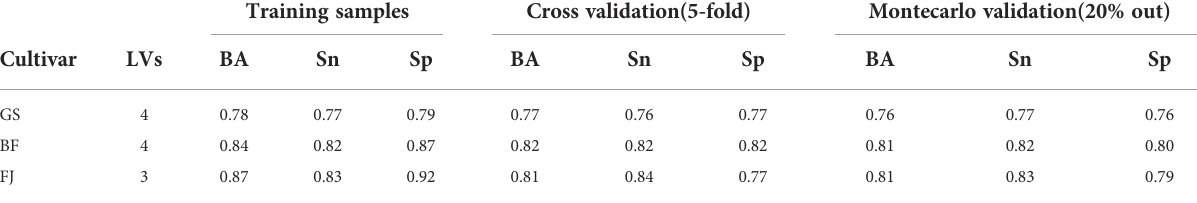
TABLE 2 Classi fi cation measures (balanced accuracy, speci fi city, and sensitivity) obtained in fi tting, cross validation (with 5 groups split in Venetian blinds and Montecarlo approach) for the three apple cultivars ( ‘ Granny Smith ’ -GS, ‘ Brook fi eld ’ -BF, and ‘ Fuji ’ -FJ). Training samples Cross